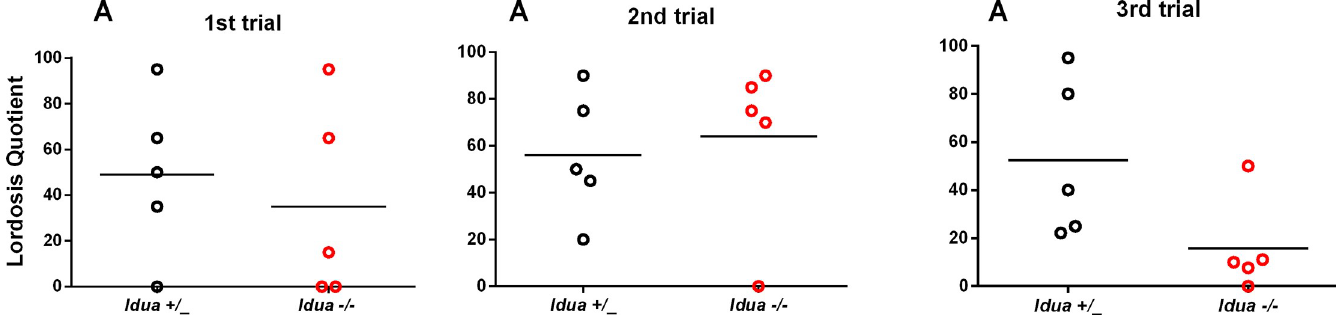
Fig 2. Analysis of female sexual behaviour. Two-month-old Idua +/_ and Idua -/- female mice were accompanied through three consecutive oestrous cycles. In the third proestrus phase, they were exposed to an experienced male to evaluate sexual behaviour. The analysis was repeated for the two following proestrus phases. The experiment was performed under dim-red light, for 15 minutes or until the completion of 20 mounts. Statistical analysis: generalized estimating equations.